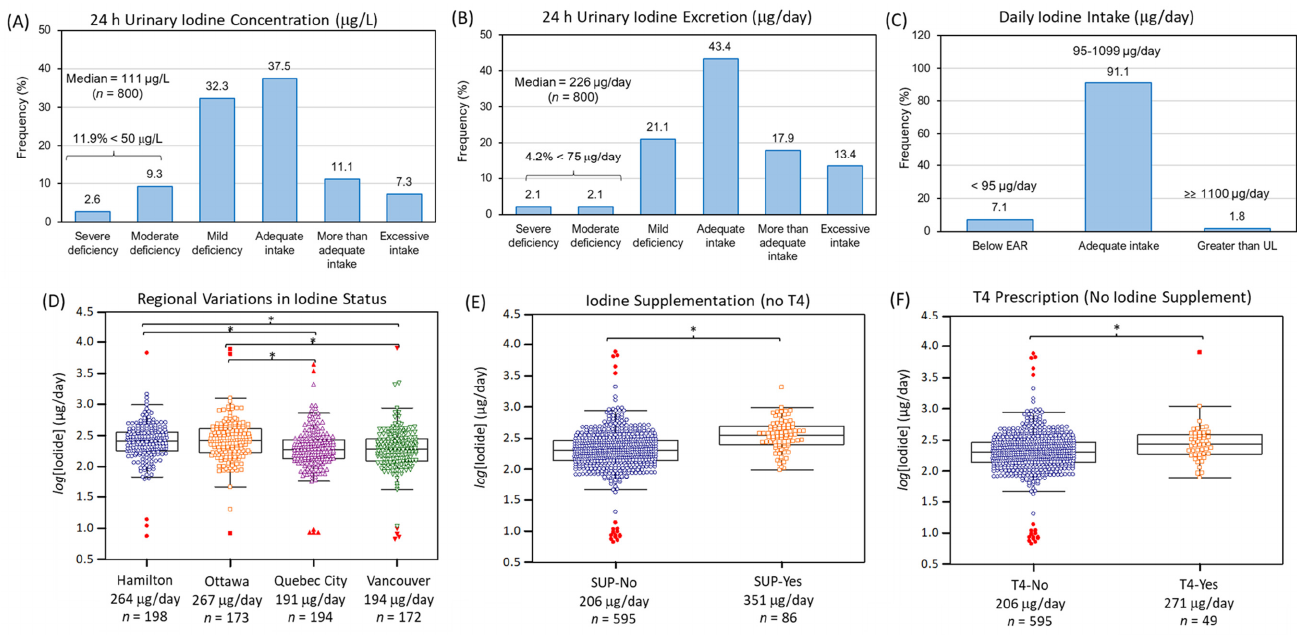
Figure 1. The iodine status of participants from the PURE-24USE study ( n = 800) based on ( A ) 24 h UIC ( g/L) and ( B ) 24 h UIE ( g/day). Median iodine concen- trations indicated iodine adequacy (111 g/L or 226 g/day, where error is ±IQR) with a low prevalence of moderate to severe iodine deficiency in the population (<20%). ( C ) Daily iodine intake confirmed only a small fraction of adult Canadians in our cohort were below EAR (7.1%, <95 g/day) or greater than UL (1.8%, ≥1100 g/day). ( D ) Regional variations in iodine nutrition were found with residents from Quebec City and Vancouver having lower iodine status than Hamilton or Ottawa ( F = 8.80, p = 9.82 × 10 −6 , n = 737; where * p < 0.014 for pairwise comparisons). Participants who ( E ) reported use of multivitamin supplements containing iodine, but no T4 ( F = 42.3, p = 1.52 × 10 −10 , n = 681), or ( F ) were prescribed T4, but not taking iodine supplements ( F = 9.71, p = 1.91 × 10 −3 , n = 644) had greater iodine status than controls. All ANCOVA were adjusted for age, sex, BMI, total caloric intake, AHEI score, education, alcohol use, and smoking status.